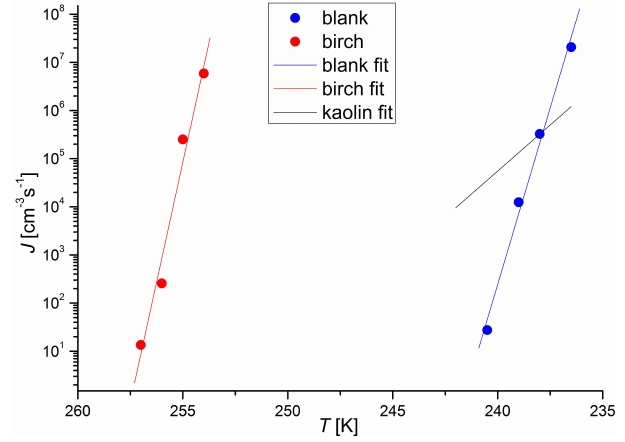
Fig. 5. Plot of the nucleation rates J blank The kaolin fit was taken from Murray et al. (2011), and converted into comparable units by multiplication with 0.7162cm − 1 , which is the ratio of maximum particle surface per droplet and the average droplet